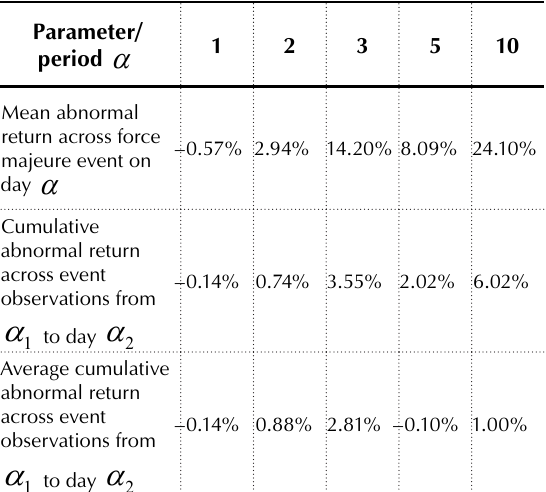
Table 10. Cumulative abnormal returns for the PFST returns over the period 1991–2018: natural